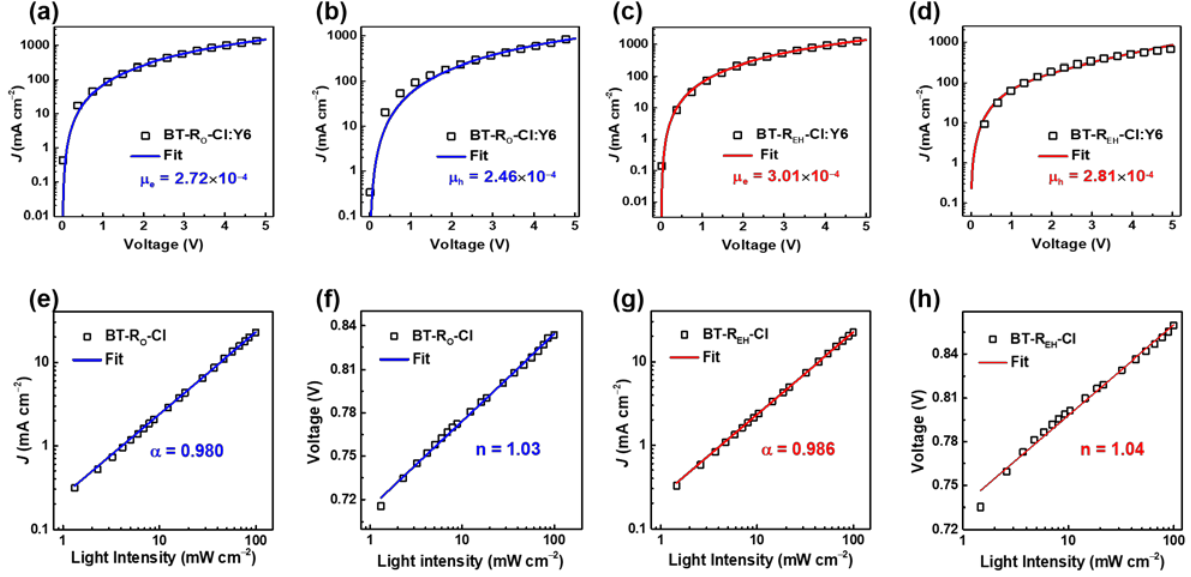
Figure 4. ( a – d ) J – V characteristics in the dark for electron and hole mobility measurement for BT-R O -Cl:Y6 and BT-R EH -Cl:Y6 blended films. ( e – h ) The fitted results of J sc and V oc under various incident light intensities. Fitted equations: J sc ∝ I α and V oc ∝ n ( kT/q ) ln(I)